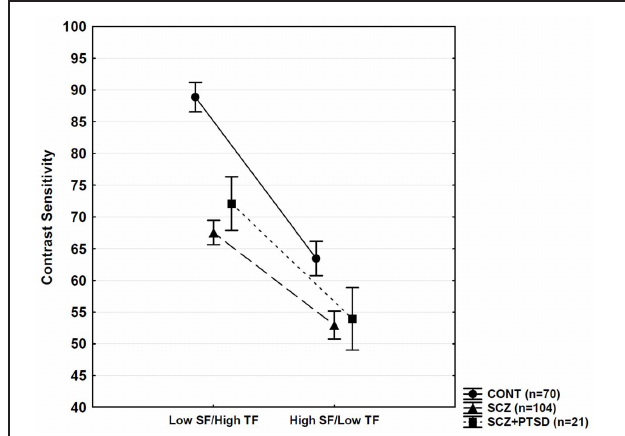
FIGURE 2 | Visual contrast sensitivity. CONT, control; SCZ, schizophrenia; PTSD, posttraumatic stress disorder; SF, spatial frequency; TF, temporal frequency. Error bars indicate 95% confidence intervals. SCZ and SCZ + PTSD patients showed similar reductions in sensitivity relative to controls ( p < 0 . 001, Tukey HSD for unequal Ns).